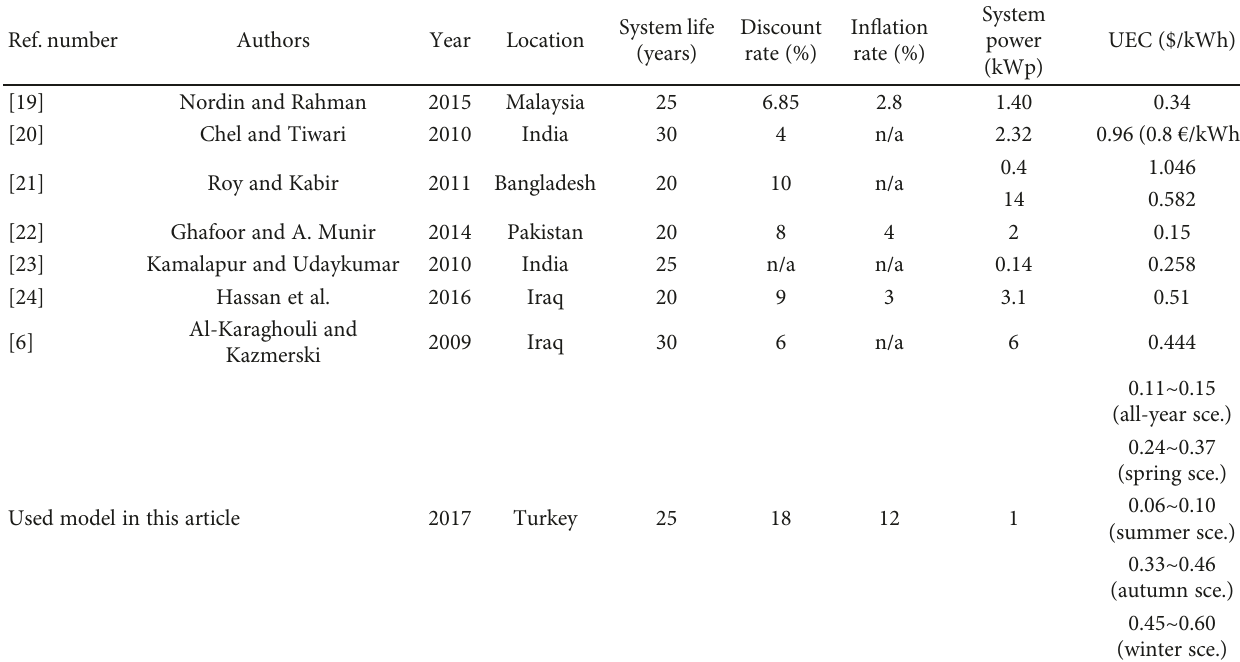
Table 4: Comparison of studies in the literature in terms of UEC. Ref.